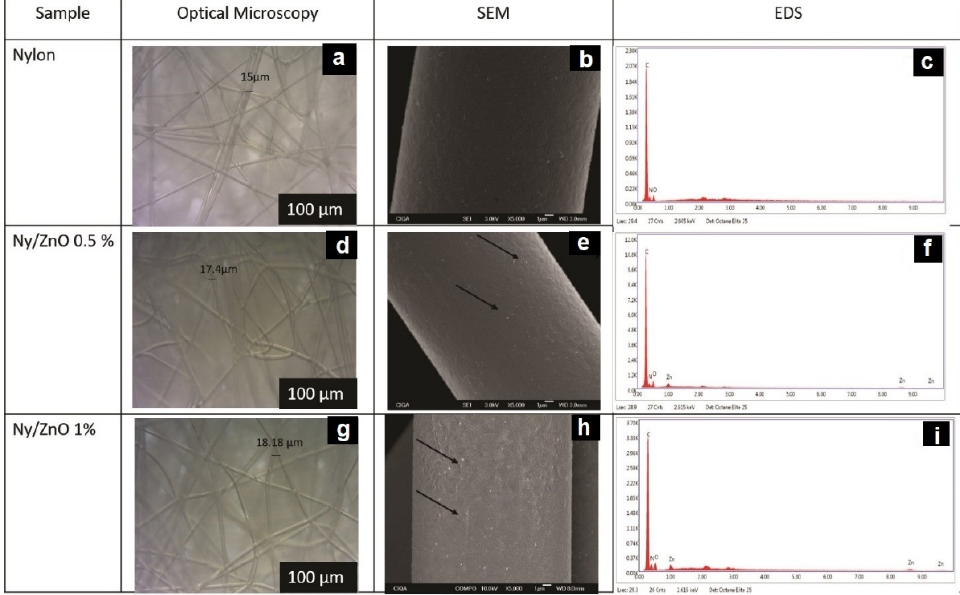
Figure 2. Optical microscopy of ( a ) nylon; ( d ) Ny/ZnO 0.5; and ( g ) Ny/ZnO 1. SEM images of ( b ) nylon; ( e ) Ny/ZnO 0.5; and ( h ) Ny/ZnO 1. EDS spectra of ( c ) nylon; ( f ) Ny/ZnO 0.5; and ( i ) Ny/ZnO 1.